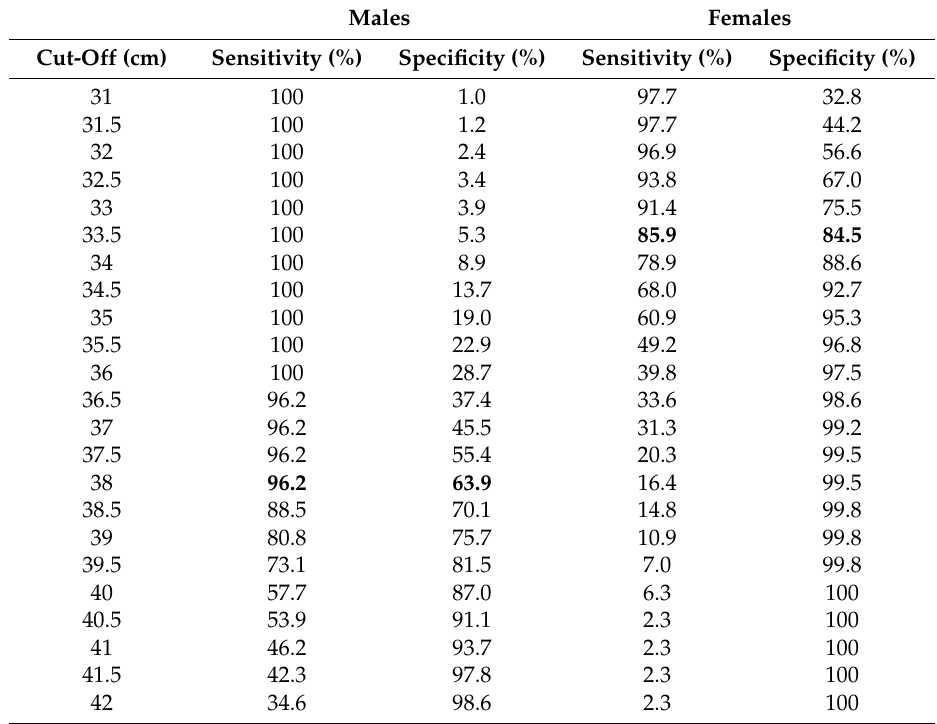
Bold values indicate the optimal cut-off NC levels based on maximum of (Sensitivity + Specificity) for determining subjects with central obesity (WC measurement > 102 cm, NC ≥ 38 cm in males and WC > 88 cm, NC ≥ 33.5